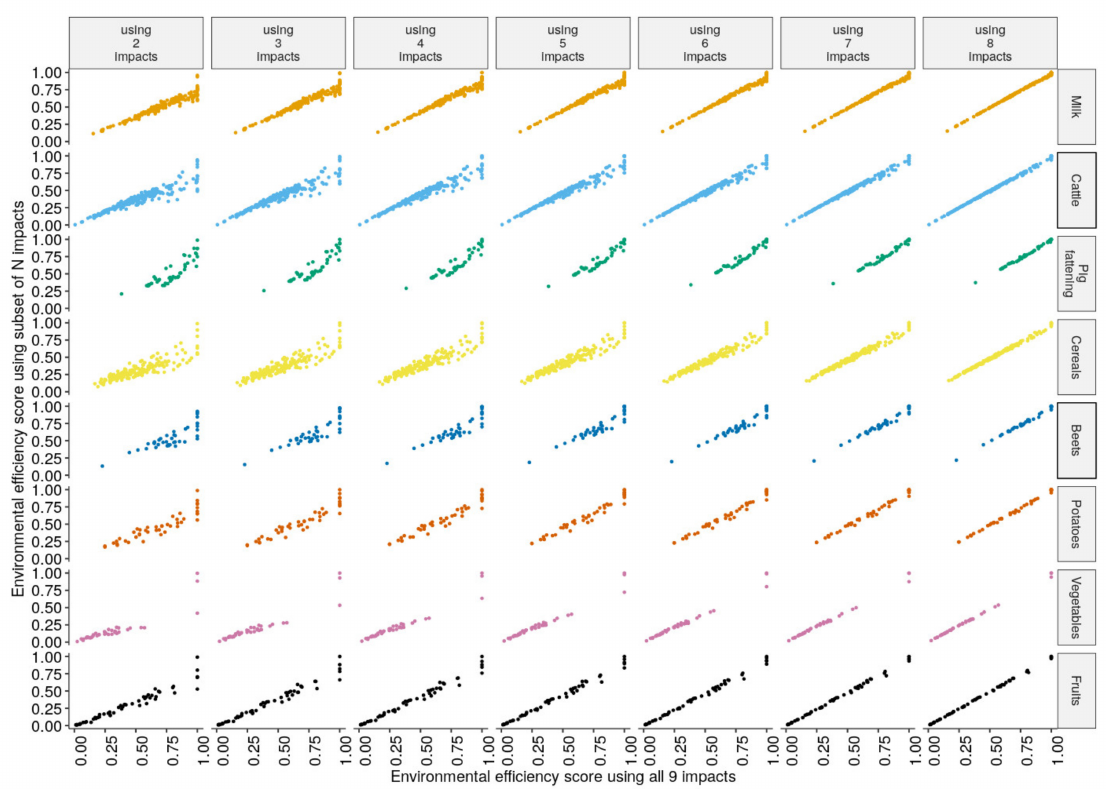
Figure A8. Environmental efficiency without N impacts. For each subplot, only N impacts were used. The values on the x -axis are the original environmental efficiency scores, the value on the y -axis are the scores calculated using only a subset of N